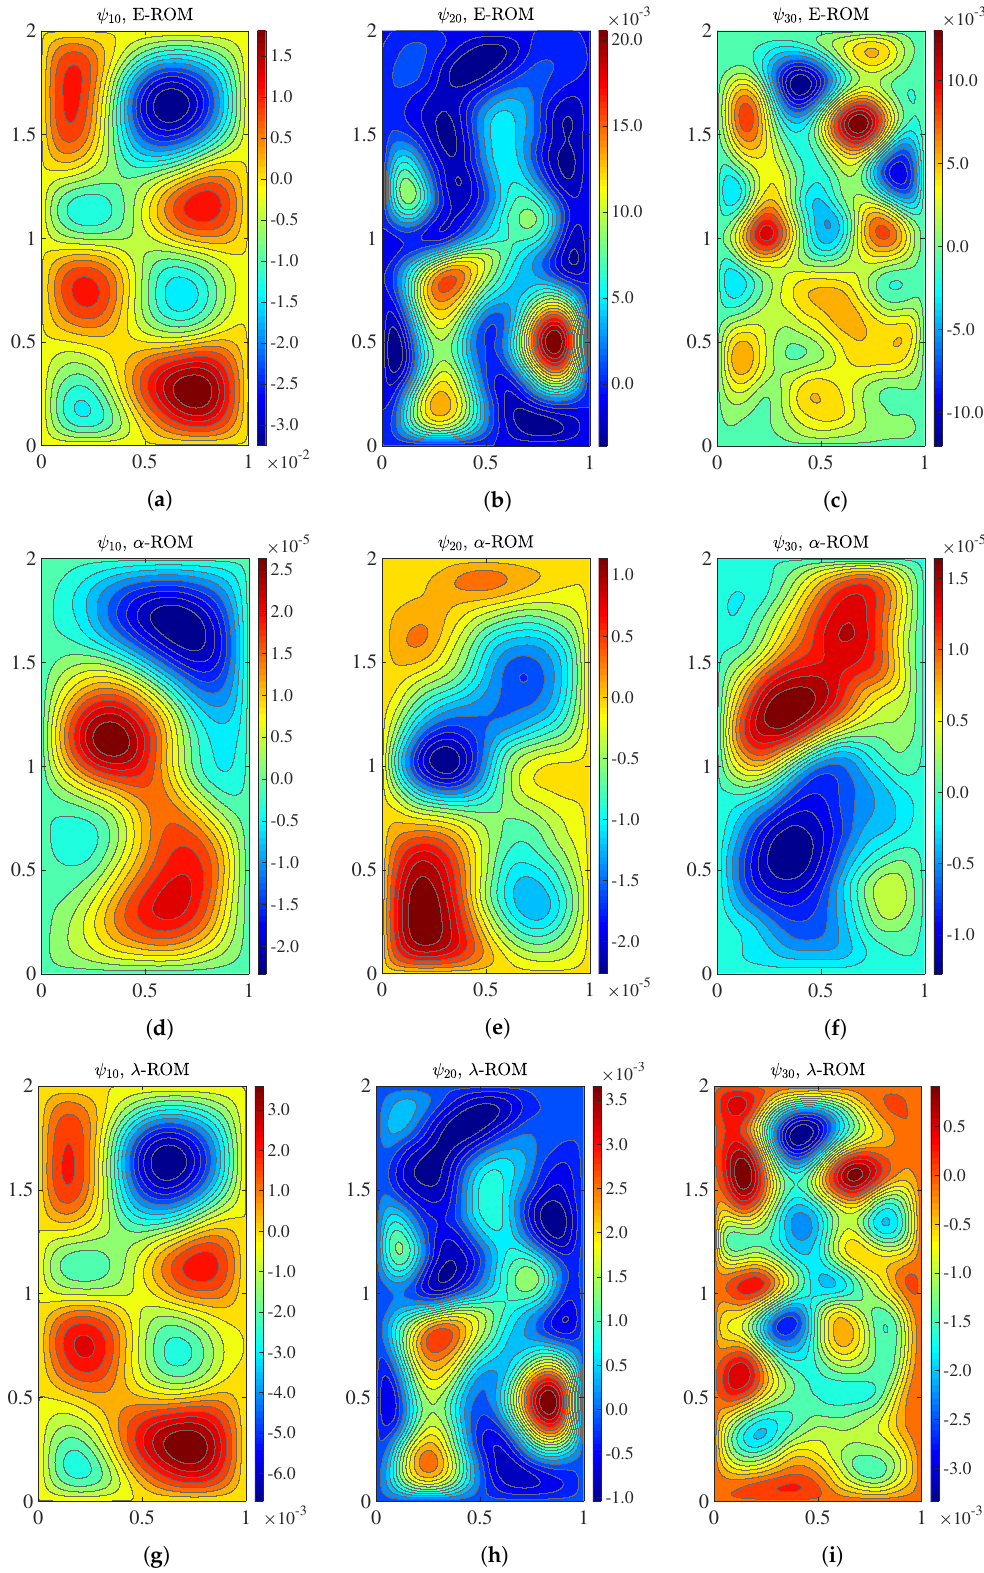
Figure 3. ROM basis functions ψ 10 (plots ( a , d , g )), ψ 20 (plots ( b , e , h )), and ψ 30 (plots ( c , f , i )) for the standard E-ROM (plots ( a – c )), new Lagrangian α -ROM with α = 10 4 (plots ( d – f )), and new Lagrangian λ -ROM (plots ( g – i